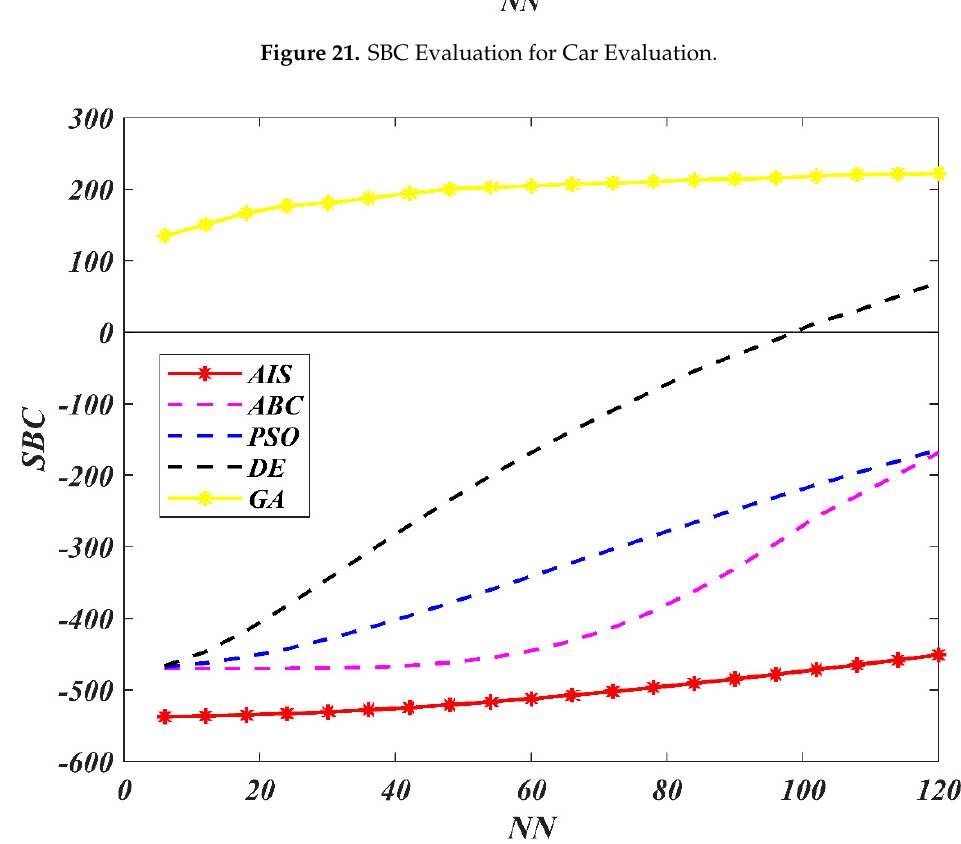
Figure 22. SBC Evaluation for Postoperative Patient.